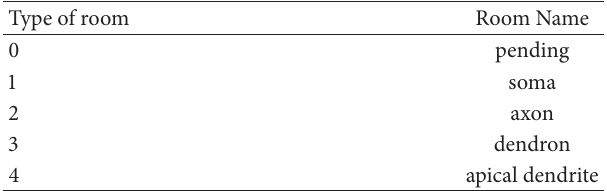
Table 2: The type of neuron room. Type of room